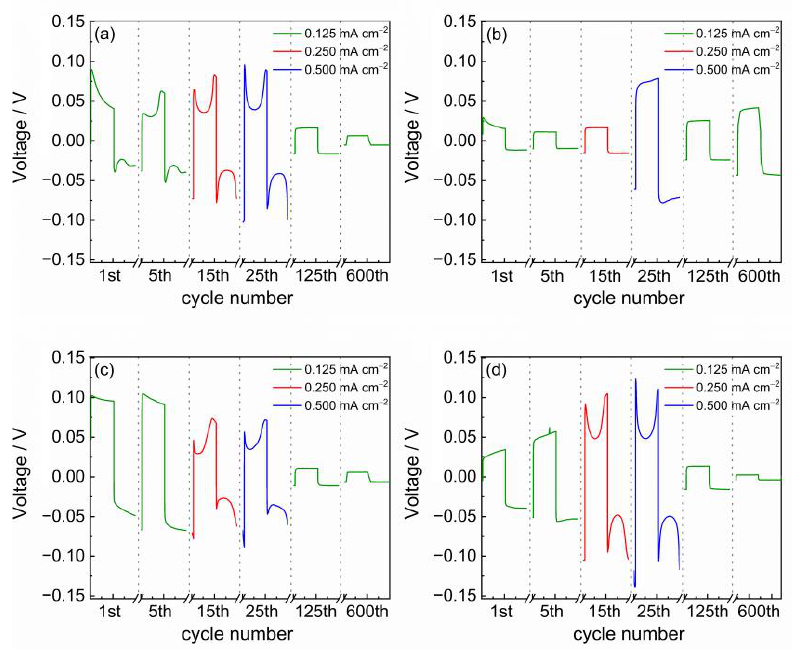
Figure 7. Selected overvoltage profiles of lithium deposition/stripping of Li||Li symmetric cells with ( a ) LP30, ( b ) LP30-NH 4 PF 6 , ( c ) LP30-TMAPF 6 , ( d ) LP30-TEAPF 6 electrolytes at 0.125 mA cm −2 (green), 0.250 mA cm −2 (red) and 0.500 mA cm −2 (blue).